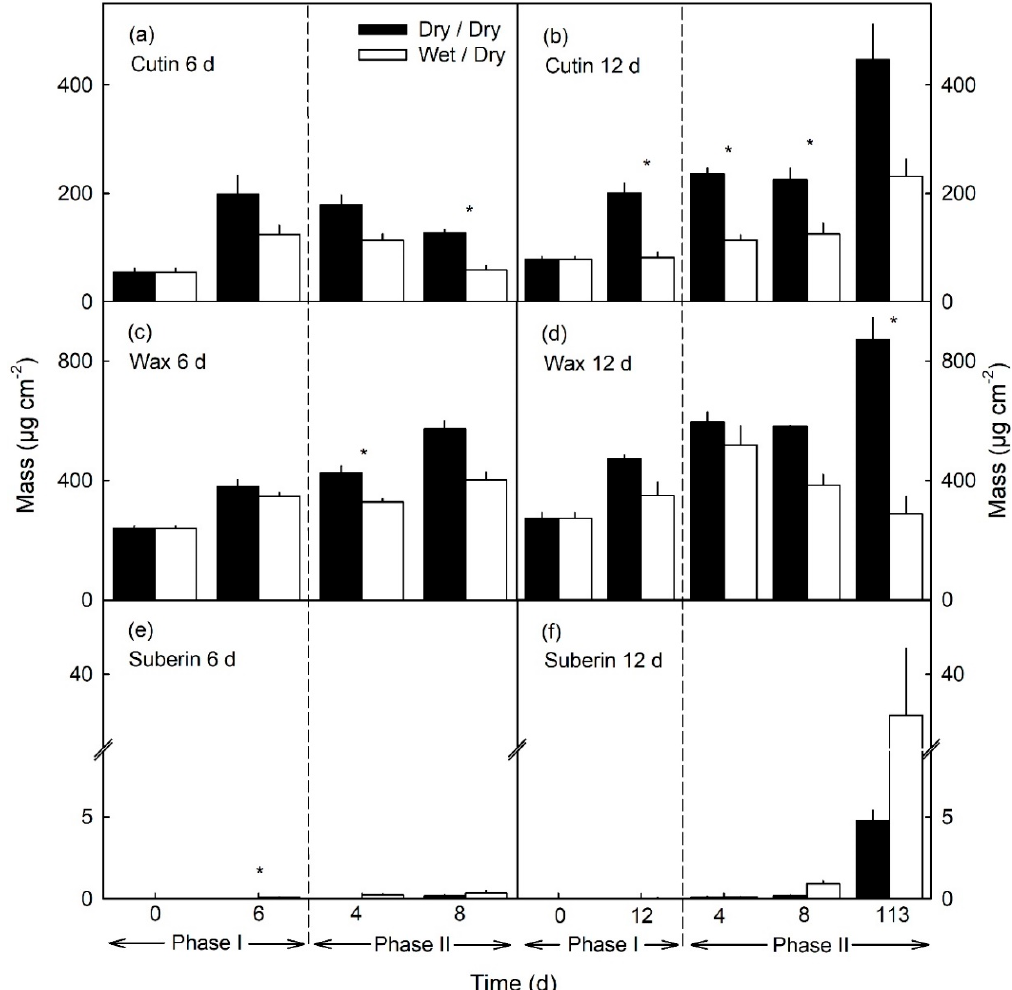
Figure 9. Total mass of cutin ( a , b ), wax ( c , d ) and suberin ( e , f ) in patches of the apple fruit skin during exposure to moisture (Phase I) and after exposure to moisture had been discontinued (Phase II). During Phase I, a patch of the skin was exposed to moisture for 6 d ( a , c , e ) or 12 d ( b , d , f ) beginning at 31 days after full bloom (DAFB) (wet). During the subsequent Phase II, the exposure to moisture was discontinued and the patch exposed to the atmosphere (dry). Moisture exposed patches of fruit skin are referred to as wet/dry, unexposed control patches as dry/dry. The end of the moisture exposure period is indicated by the vertical dashed line. The data represent the means ± SE of two or three samples comprising five fruits each. Significance of differences between dry/dry and wet/dry at p ≤ 0.05 is indicated by ‘*’ (Student’s t